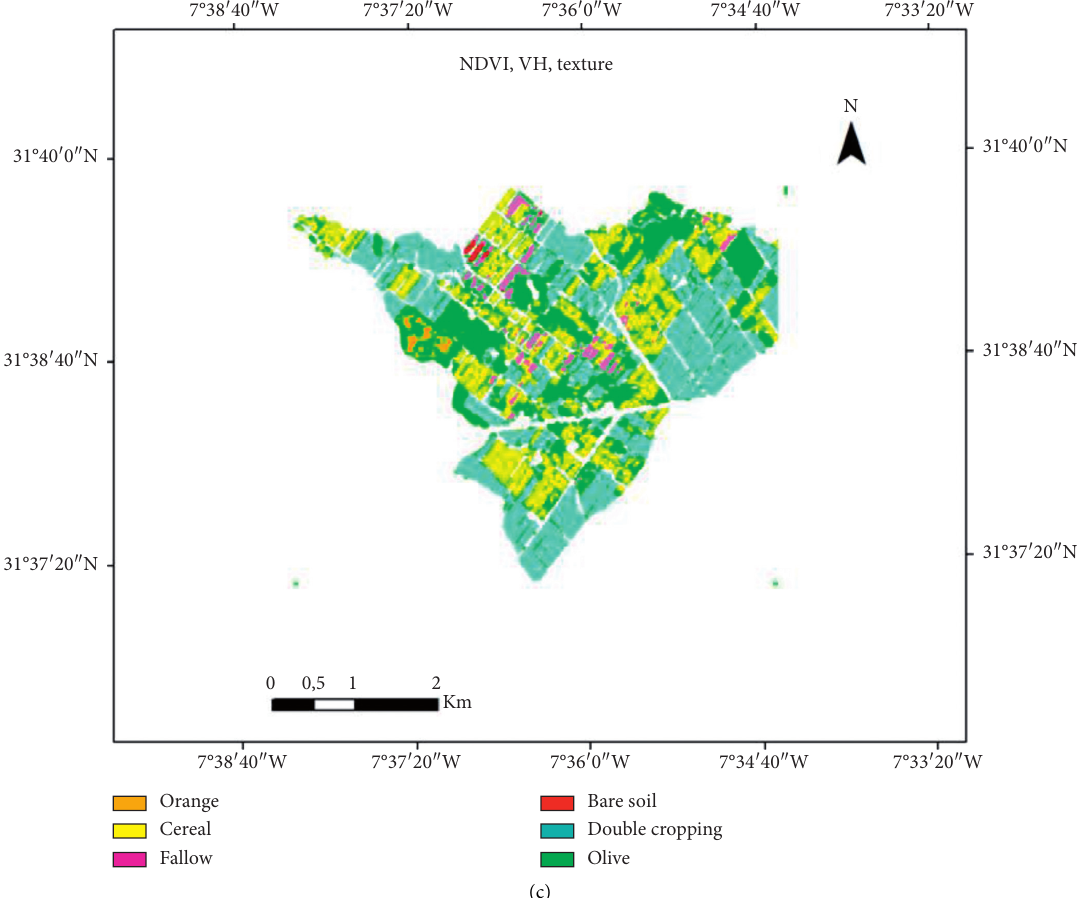
Figure 12: Final land use maps. (a) Optical (85.83%, K � 0.81), (b) radar (81.12%, K � 0.75) and (c) optical combined with SAR (88.90%, K �